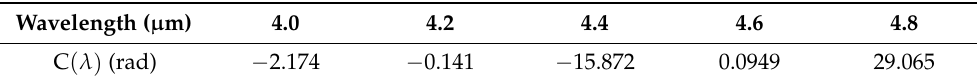
Table 1. Optimized phase correction at wavelengths from 4.0 to 4.8 μm .